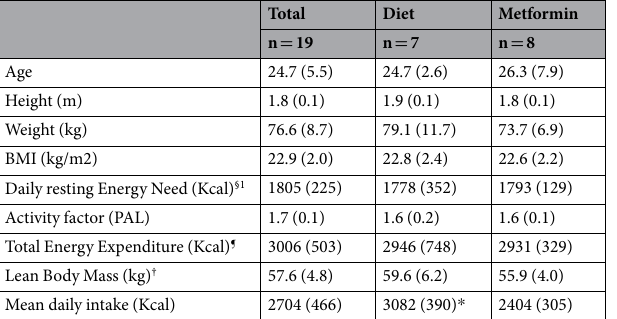
Table 1. Baseline characteristics of the three intervention groups. Notes: Values are presented as mean ± S.D. * Comparison between hypocaloric diet group and metformin group p = 0.008; § Calculated with Harris and Benedict equation (ref. 36 for men. Daily resting Energy Need = 88.362 + (13.398 × weight (kg)) + (4.799 × length (cm)) − (5.677 × age). ¶ Total Energy Expenditure = Resting energy need × PAL. † According to formula of Hume (ref. 37 ). Lean body mass = (0.32810 × weight (kg)) + (0.33929 × length (cm)) −